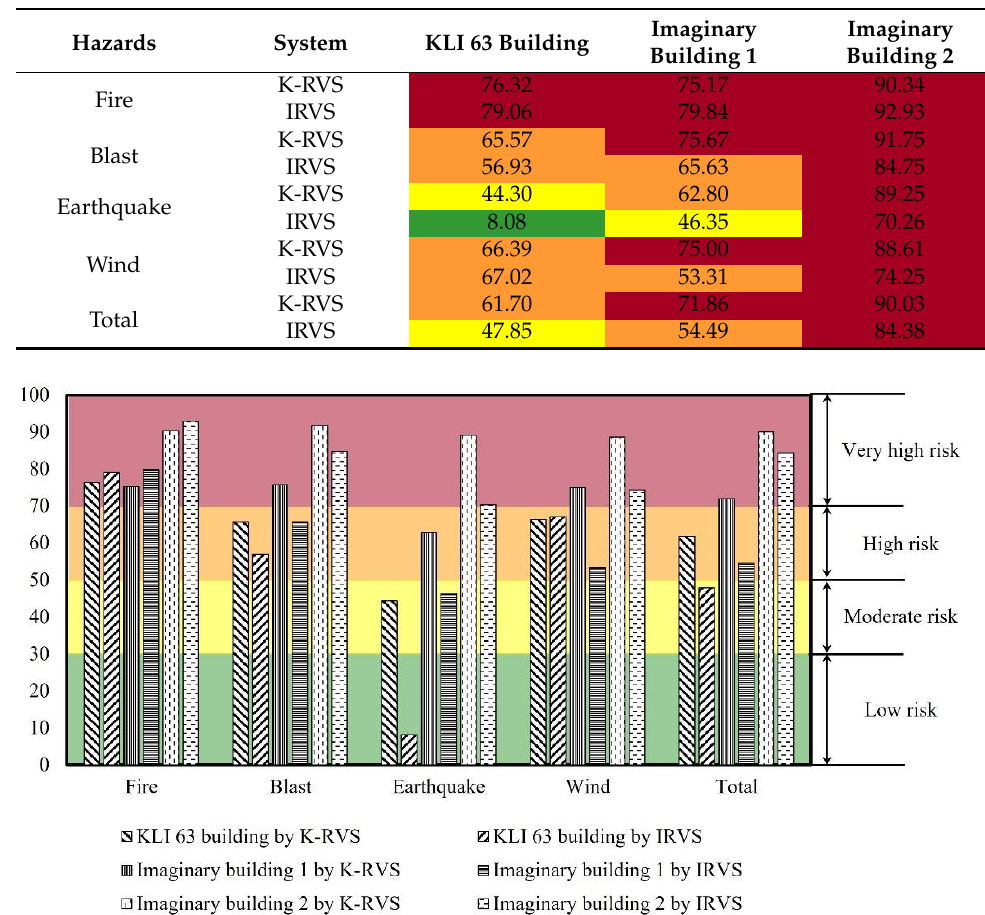
Table 12. Score by each hazard and final score from K-RVS and IRVS.